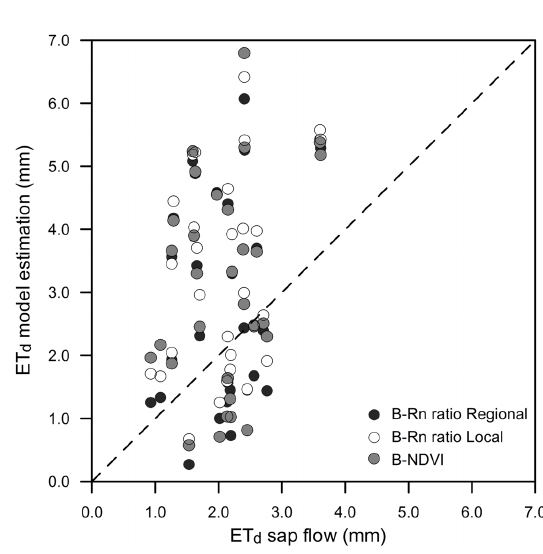
Fig. 5. Relationship between daily evapotransporation (ET d ) calculated from sap flow measurements and modelled using TERRA MODIS data and the B parameter estimation in mm · day − 1 . B - R n ratio regional is the B approach using the re- gional R n ratio, B - R n ratio local is the B approach using the local R n ratio and B-NDVI is the B approach using the NDVI.